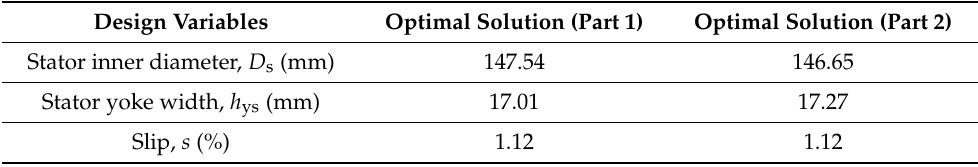
Figure 8. Visualization of the process involved in the proposed surrogate optimization routine. Table 8. Comparison of design variables of the optimal solution (part 1—surrogate optimization vs. part 2—pattern search) from the proposed surrogate optimization routine 3-variable optimiza- tion